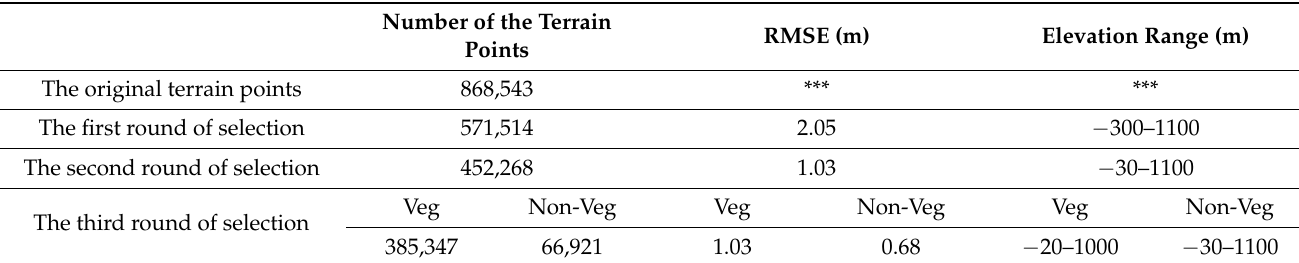
Table 2. The results for each round of